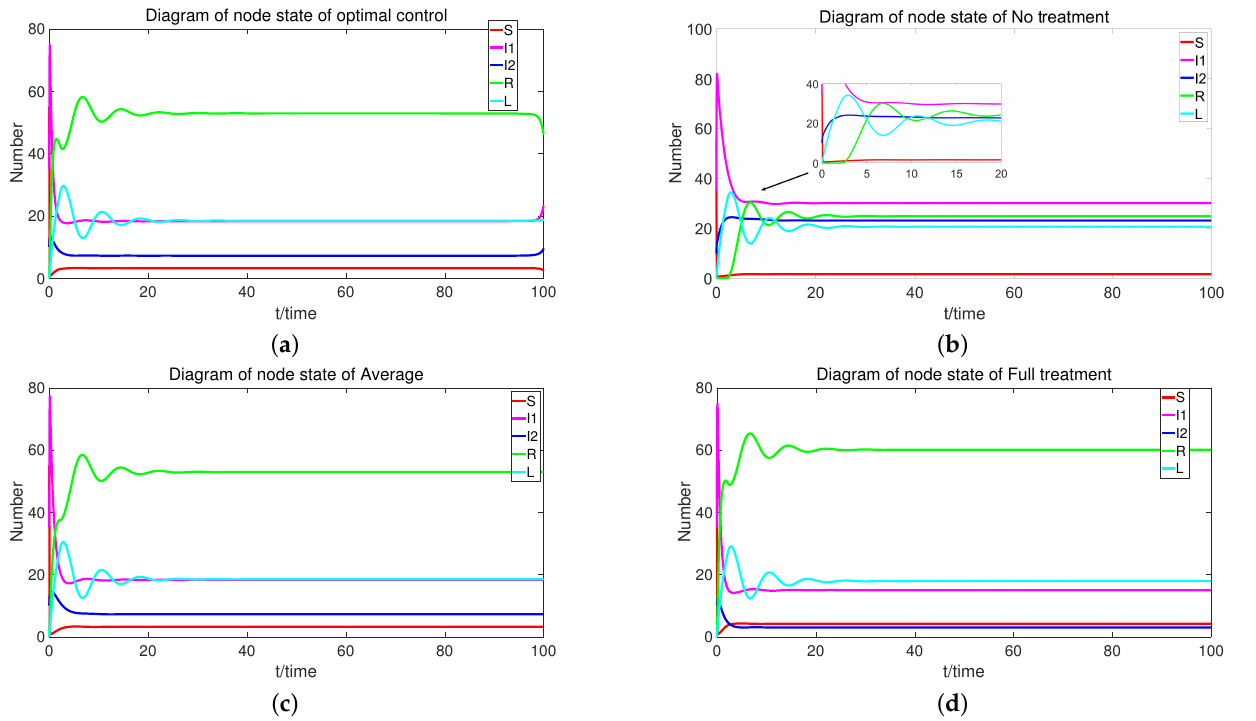
Figure 11. Variation in node numbers: ( a ) Optimal control; ( b ) No treatment control; ( c ) Average control; ( d ) Full treatment